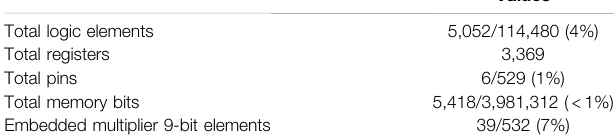
are α (cid:1) 69, [ x 0 , y 0 , z 0 ] (cid:1) [0.2900, − 0.1305, 0.8406]; and those for (cid:1) [0.2900, − 0.1288, 0.8056]. Figure 7D are α (cid:1) 72, [ x 0 , y 0 , z 0 ] Meanwhile, for the given parameters, the coexisting periodic circles or chaotic attractors are presented with initial conditions [ x 0 , y 0 , z 0 ] (cid:1) [0.01, 0, 0.01] and [ x 0 , y 0 , z 0 ] (cid:1) [ − 0.01, 0, − 0.01]. For a given α , the captured phase diagrams are put together in the same fi gure, and coexisting hidden attractors are observed in the FPGA digital circuit.